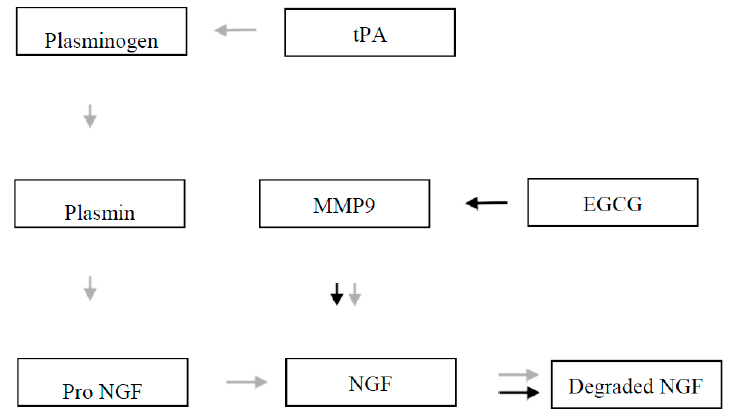
Figure 4. Diminished activity of tissue plasminogen activator (tPA) in Down syndrome brain converts less plasminogen to plasmin; this produces less proNGF to activate nerve growth factor (NGF) (gray arrows). Overexpressed MMP-9 further reduce NGF (black arrows). Degradation of NGF can